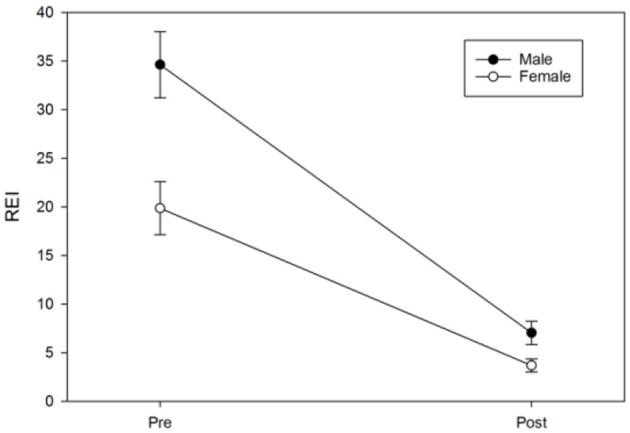
Sex differences in pre-post REI trends. The error bar represents the standard error.